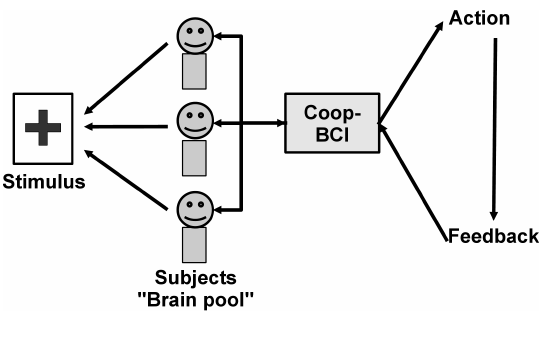
Figure 2. Cooperative BCI based on the detection of